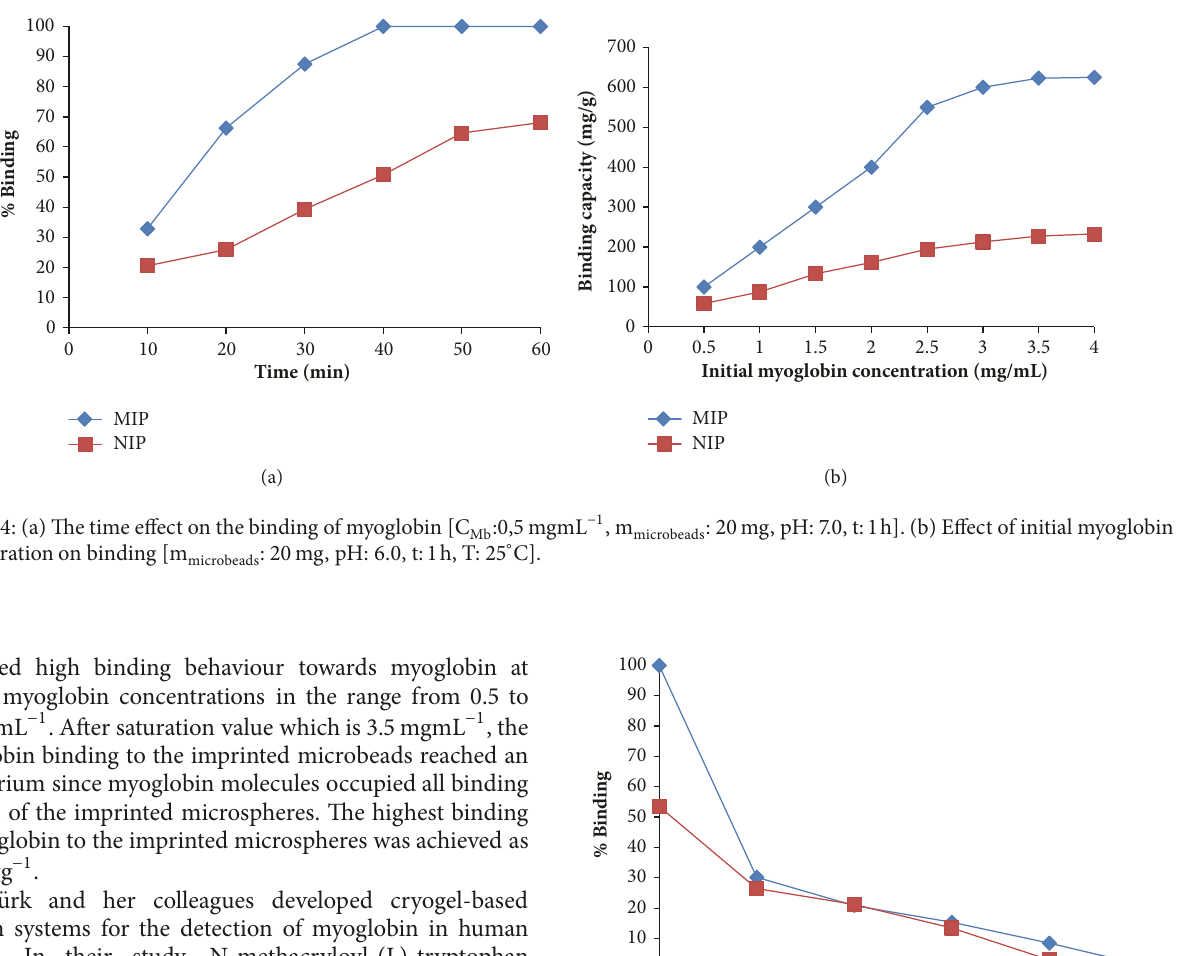
regions of the imprinted microspheres. The highest binding of myoglobin to the imprinted microspheres was achieved as 623 mgg −1 .